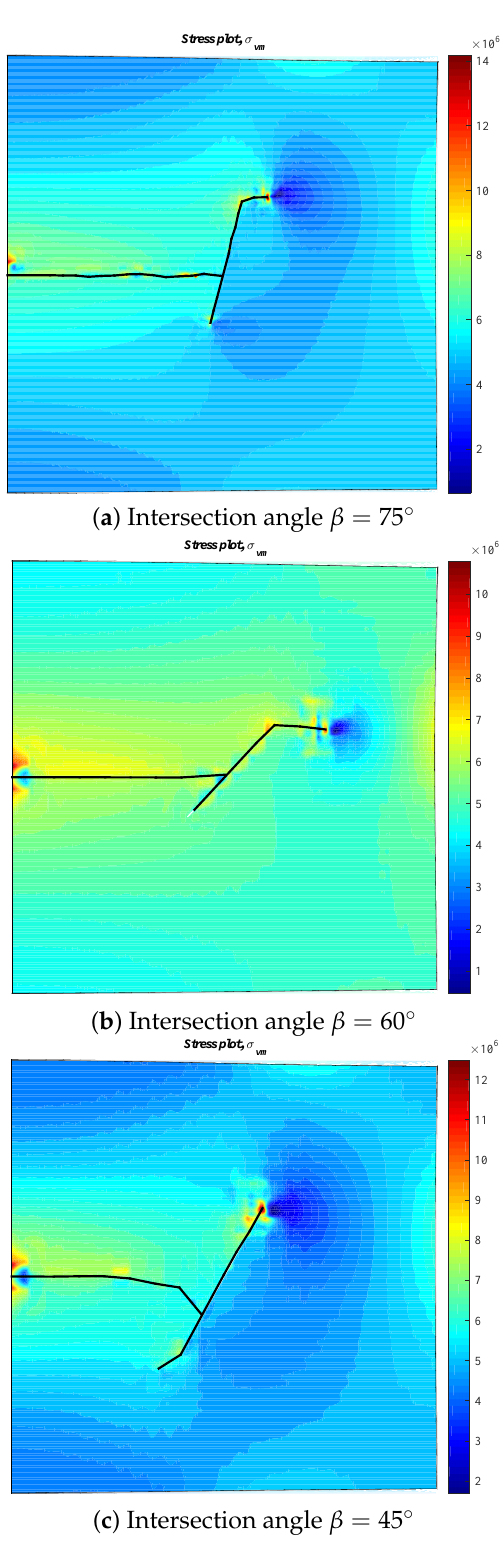
Figure 16. Von-Mises stress distributions at different levels of intersection angle between HF and